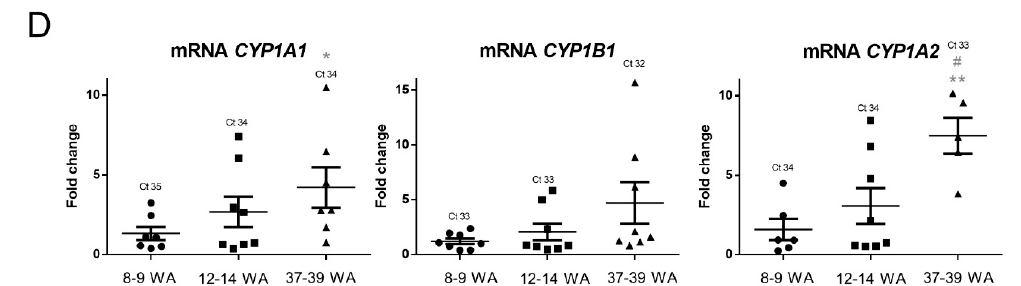
Figure 1. Placental expression of aryl hydrocarbon receptor (AhR) and relevant biomarkers during pregnancy. Total mRNAs were extracted from chorionic villi of eight placentae at 8–9 weeks of amenorrhea (WA), at 12–14 WA and at 37–39 WA (term). ( A ) Levels of β hCG , hPL , PLGF , GH2, CYP11A1, and CYP19 were determined by RT-qPCR and normalized to the geometric mean of HPRT , RPL13 , and 18S transcripts, and reported to CK7 ( KRT7 ). The means (long horizontal lines) and standard deviations (short horizontal lines) of eight independent experiments are shown. ** compared to 8–9 WA p < 0.01; ## compared to 12–14 WA p < 0.01; ### compared to 12–14 WA p < 0.001; **** compared to 8–9 WA p < 0.0001; #### compared to 12–14 WA p < 0.0001. Ct is the raw value of the gene of interest without normalization to reference genes and to KRT7 . ( B ) Levels of AhR , AhRR , and ARNT were determined by RT-qPCR and normalized to the geometric mean of HPRT , RPL13 , and 18S transcripts, and reported to CK7 ( KRT7 ). The means (long horizontal lines) and standard deviations (short horizontal lines) of eight independent experiments are shown. ** compared to 8–9 WA p < 0.01; ## compared to 12–14 WA p < 0.01; *** compared to 8–9 WA p < 0.001; ### compared to 12–14 WA p < 0.001; **** compared to 8–9 WA p < 0.0001; #### compared to 12–14 WA p < 0.0001. Ct is the raw value of interest gene without normalization to reference genes and to KRT7 . ( C ) Total protein were analyzed by immunoblotting using AhR antibody alone or pre-incubated with its blocking peptide, AhR nuclear translocator (ARNT) antibody, and β -Actin, the last used as a loading control. The graph represents the total amount of AhR protein (2 bands) relative to β -Actin levels determined by quantification of immunoblot analysis using the Odyssey System Imager. The means (long horizontal lines) and standard deviations (short horizontal lines) of four distinct placentae per stage of pregnancy are shown (* p < 0.05). ( D ) Levels of CYP1A1 , CYP1B1 , and CYP1A2 were determined by RT-qPCR as above. The means (long horizontal lines) and standard deviations (short horizontal lines) of eight independent experiments are shown. Ct is the raw value of interest gene without normalization to reference genes and to KRT7 . * compared to 8–9 WA p < 0.05; # compared to 12–14 WA p < 0.05; ** compared to 8–9 WA p < 0.01. Table 1. The expression of AhR-target genes involved in the oxidative defense system during ontogeny. Pregnancy Period mRNA